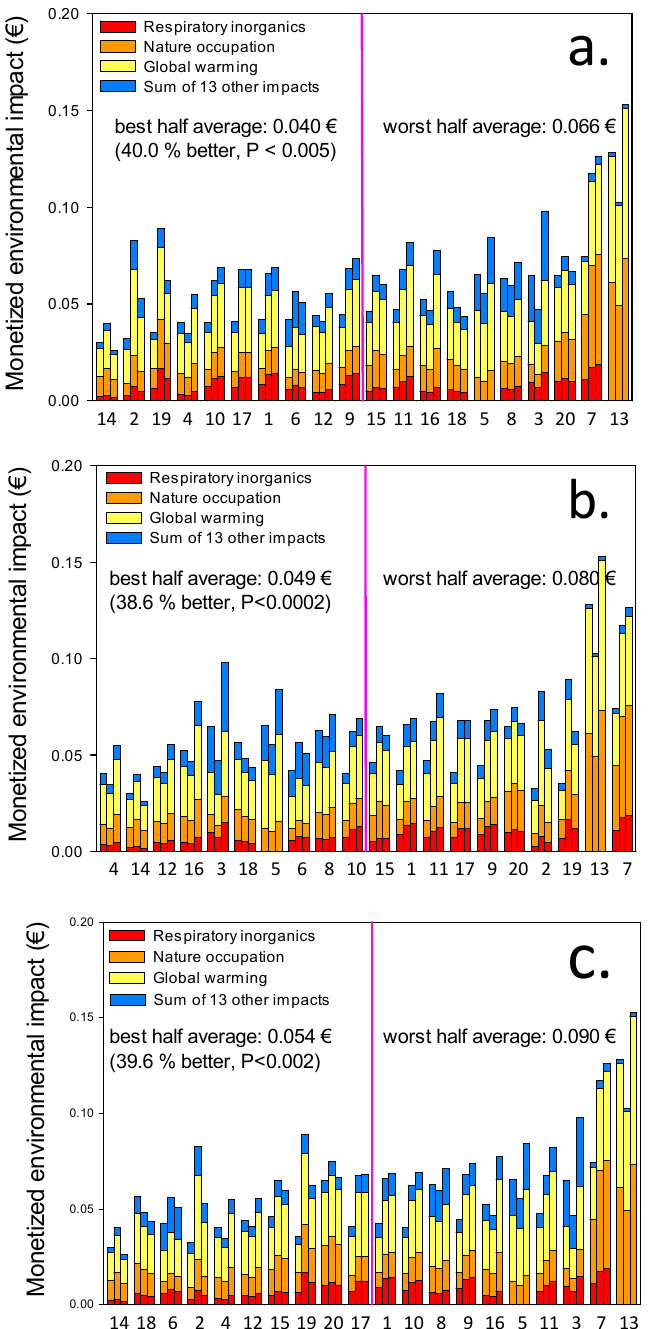
half in terms of climate impact is given in the figure together with the relative difference and associated significance level ( t ‐ test).